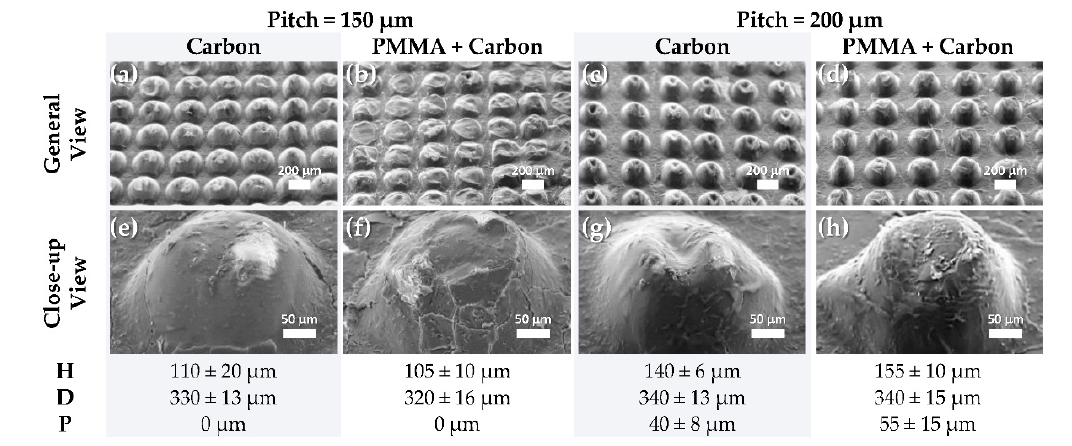
Figure 2. SEM images of s-PDMS semi-spheres (diameter = 200 µm). ( a – d ) General view of semi- spheres with a theoretical pitch of 150 µ m (a and b) or 200 µ m ( c , d ) and carbon coating only ( a , c ) or both PMMA and carbon coating ( b , d ). ( e – h ) Close-up view of semi-spheres with a theoretical pitch of 150 µ m ( e , f ) or 200 µ m ( g , h ) and carbon coating only ( e , g ) or both PMMA and carbon coating ( f , h ). At the bottom are the average values ± standard deviation of the real height (H), diameter (D), and pitch (P) of the